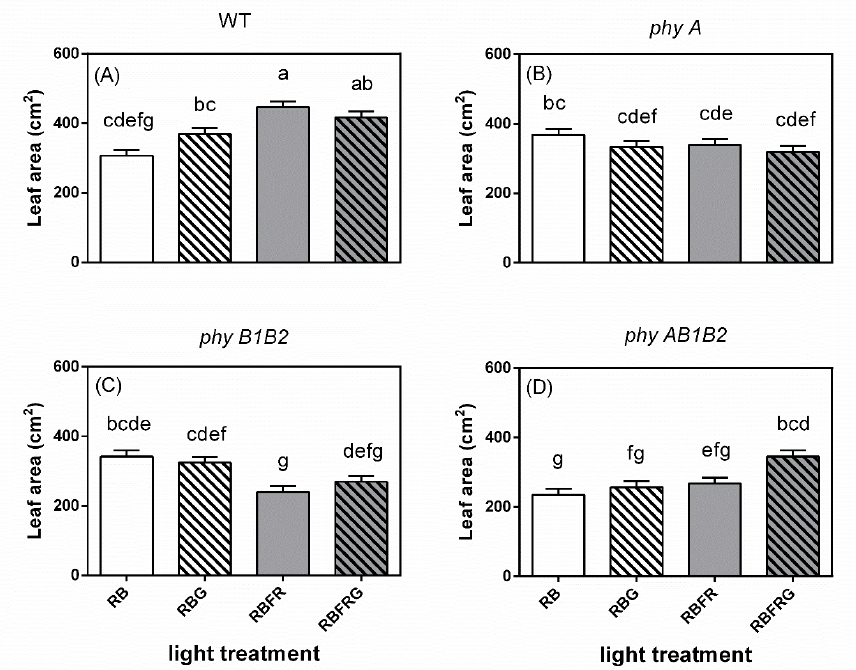
Figure 6. Effect of partial (20%) substitution of red/blue (RB; 3:1) with green (G) light in the presence or absence of far-red light (FR) on the leaf area of tomato plants 21 days after treatment. Four geno- types were studied: ( A ) WT (Moneymaker, wild-type), ( B ) phyA (phytochrome A-deficient), ( C ) phyB1B2 (phytochrome B1- and B2-deficient), and ( D ) phyAB1B2 (phytochrome A-, B1-, and B2-de- ficient). Light treatment and genotype significantly interacted ( p = 0.003). Lower case letters indicate significant differences among the combinations of light treatment and genotype ( p = 0.05), thus also allowing comparisons between panels ( A – D ). Data presented are averages, with the SE based on 5 blocks ( n = 5), each containing 3 replicate plants (Exp1). 4. Discussion 4.1. No Interaction between Green and Far-Red Light on Elongation unless the PSS Changes Elongation increased when partially replacing RB with G when there was also FR in the spectrum (Figures 1 and 2). However, G did not affect elongation when the PSS values remained unchanged (Figure 3). Green light, as such, hardly affects the PSS value, but replacing 20% of the RB background with G may result in changed PSS values due to the fact that the ratio of FR to the other wavelengths changes. Therefore, a lower PSS value is a likely explanation for the increased elongation when partially replacing RB with G when there was also FR in the spectrum (Figures 1 and 2). So, based on our results, we conclude that there is no effect of G on elongation unless PSS changes. However, one study found that G increases elongation despite R/FR (hence PSS) being kept constant [5], while in an- other study, where R/FR (hence PSS) dropped when G was added, no effect of G was found on elongation [26]. In Arabidopsis , phyB is the dominant phytochrome in the control of internode elon- gation, and phyD and phyE play minor and/or redundant roles [27]. However, consistent with the results of Weller et al. [28], our data showed that the stem length of phyAB1B2 mutant plants could still respond to additional FR and a decrease in PSS when replacing